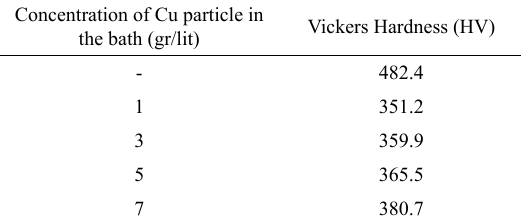
Table 12. The effect of Cu particles on the hardness of Ni-P-Cu composite coating. Concentration of Cu particle in the bath (gr/lit)